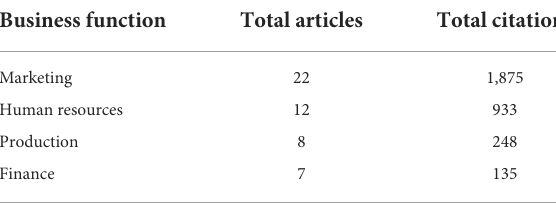
TABLE 4 List of 10 most cited